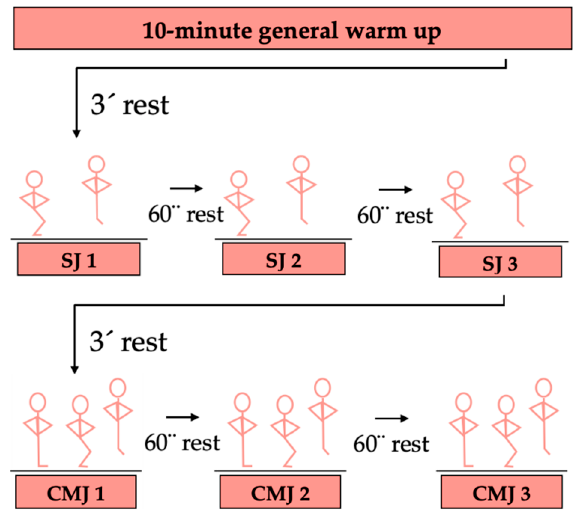
Figure 1. Experimental design. CMJ = countermovement jump test; SJ = squat jump.